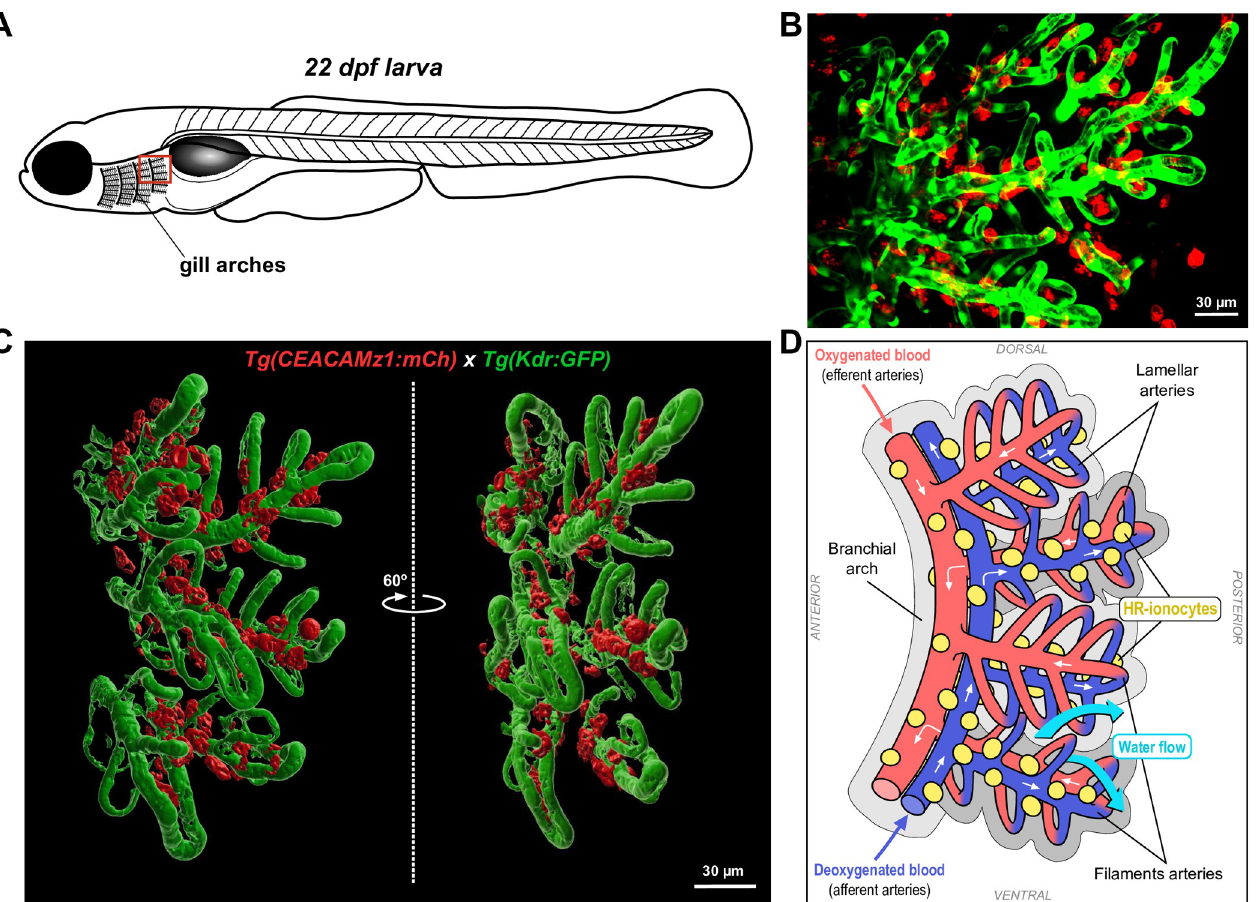
Fig 8. Distribution of CEACAMz1-positive ionocytes with respect to vasculature in the gills at late larval stages. A. Schematic representation of a juvenile zebrafish larva to highlight the part of the gills on which imaging was performed. B. Live imaging of a 22 dpf double-crossed Tg(ceacamz1 : mCherry-F) x Tg(kdr : eGFP-F) larva using spinning-disk confocal microscopy. Z-projection centred on the most posterior arch of the gills. CEACAMz1-ionocytes (red) distribute along the branchial blood vessels (green), mainly the filament arteries at this stage. C. 3D reconstruction of the most posterior branchial arch using IMARIS software. The two distinct views are rotated by 60˚. CEACAMz1-expressing cells are localized along the filament arteries on the inner side of the branchial arch, i.e. along the afferent arteries. D. Schematic representation of the 3D reconstruction visualized in C. Blood vessels are color-coded according to their oxygen content (efferent arteries in red, afferent arteries in blue). HR ionocytes expressing CEACAMz1 are displayed in yellow. The direction of water flow is indicated with blue arrows and is opposite to blood flow (white arrows).